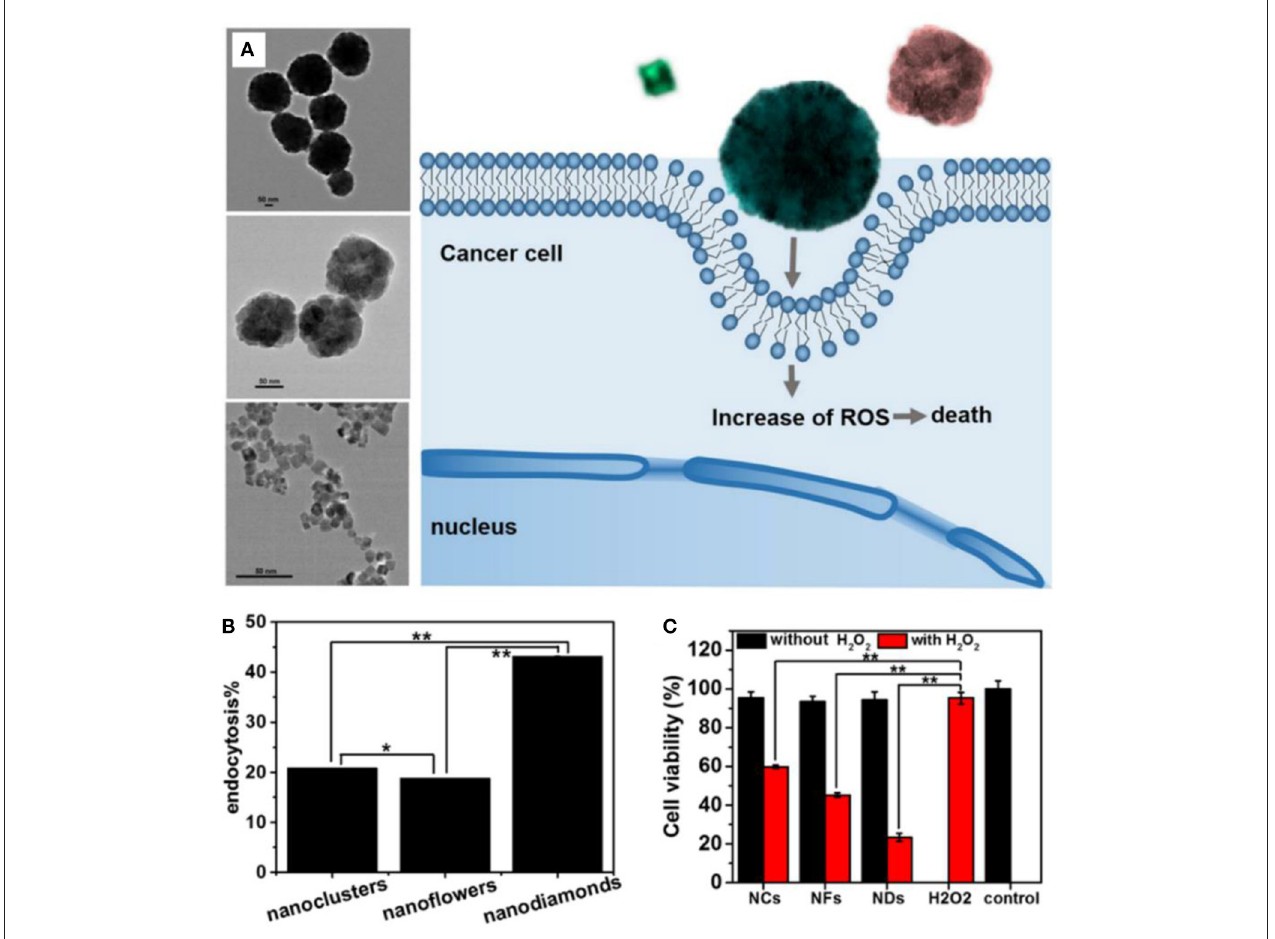
FIGURE 2 | (A) Schematic illustration for the structural effect of Fe 3 O 4 nanoparticles on ROS generation for cancer cell killing. (B) Endocytosis percentage of three kinds of Fe 3 O 4 nanoparticles. (C) Cell viability incubated with Fe 3 O 4 (1 mg/ml) alone or Fe 3 O 4 (25 µ g/ml) plus H 2 O 2 (0.625 µ M). Statistical significance, * p < 0.05,** p < 0.01. Reproduced, with permission, from Fu et al. (2017). Copyright 2017,